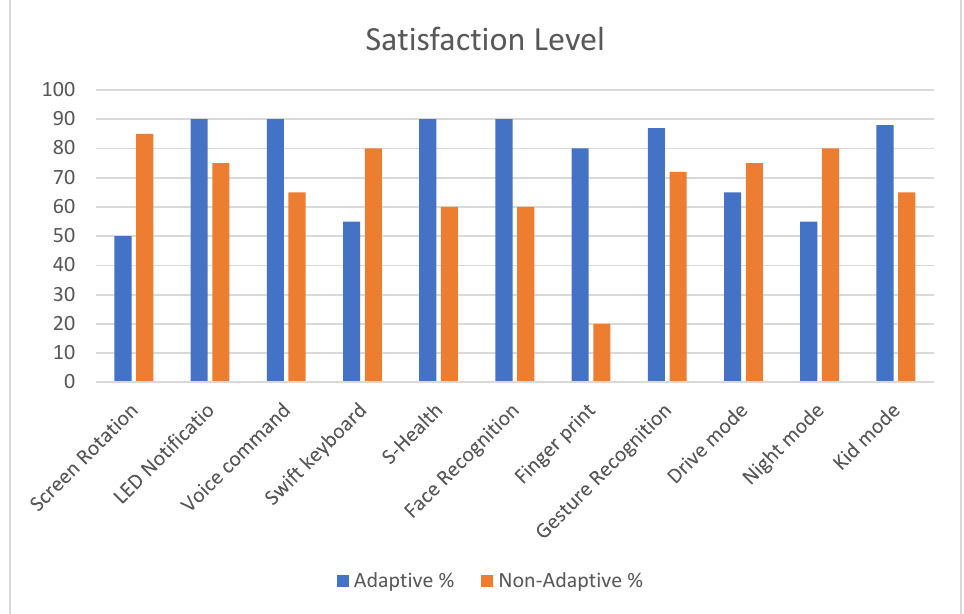
Figure 3. Satisfaction levels of adaptive and non ‐ adaptive features.